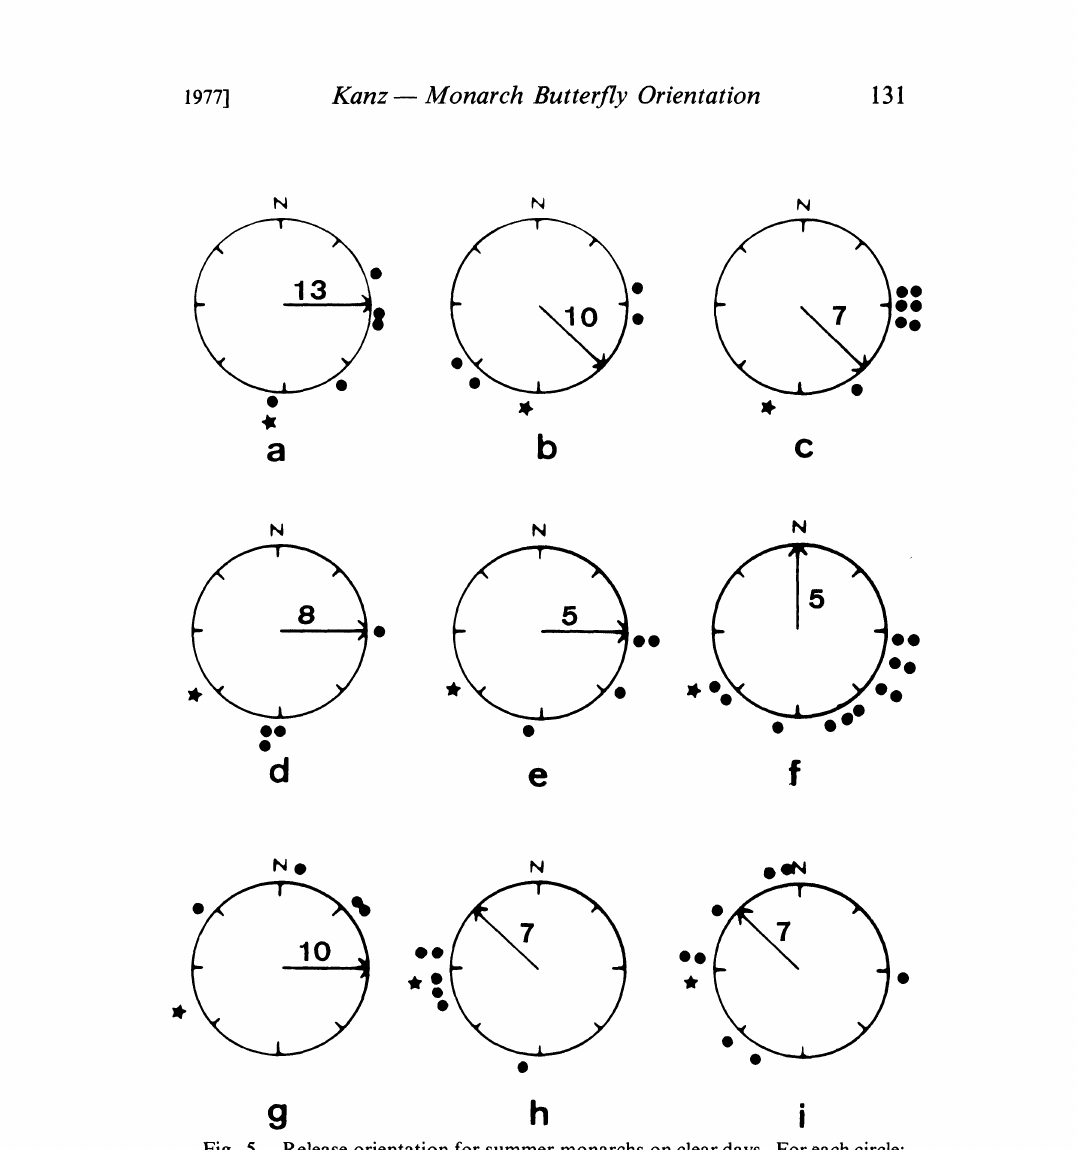
Fig. 5. Release orientation for summer monarchs on clear days. For each circle: Dot indicates the vanishing direction of a butterfly; star indicates sun position at the time of release; radial arrow indicates direction in which wind was blowing and its velocity in miles per hour; N indicates true north. Most vanishing azimuths are seen to be